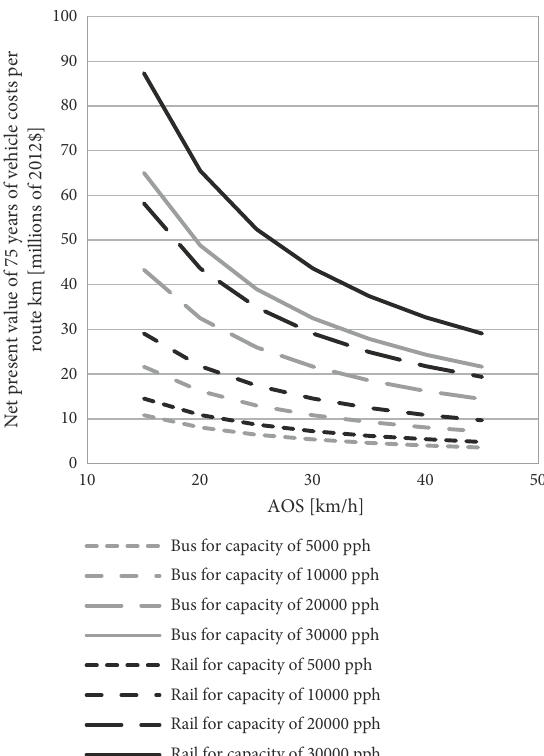
Figure 5. Lifecycle vehicle ownership cost as a function of AOS by technology and